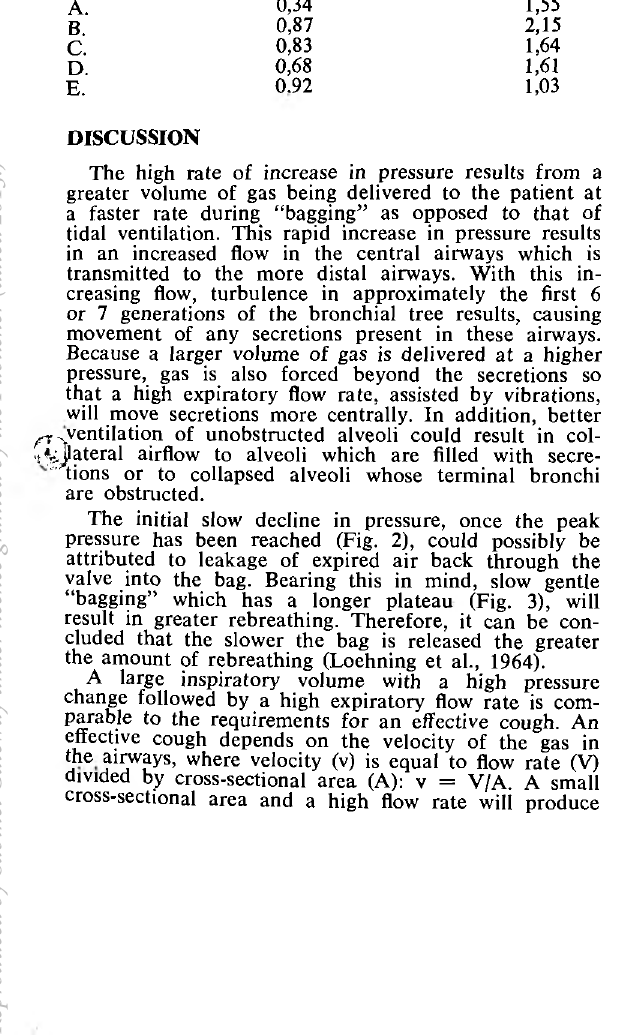
' Table 2. Gradients of graphs of patients during ventilation and